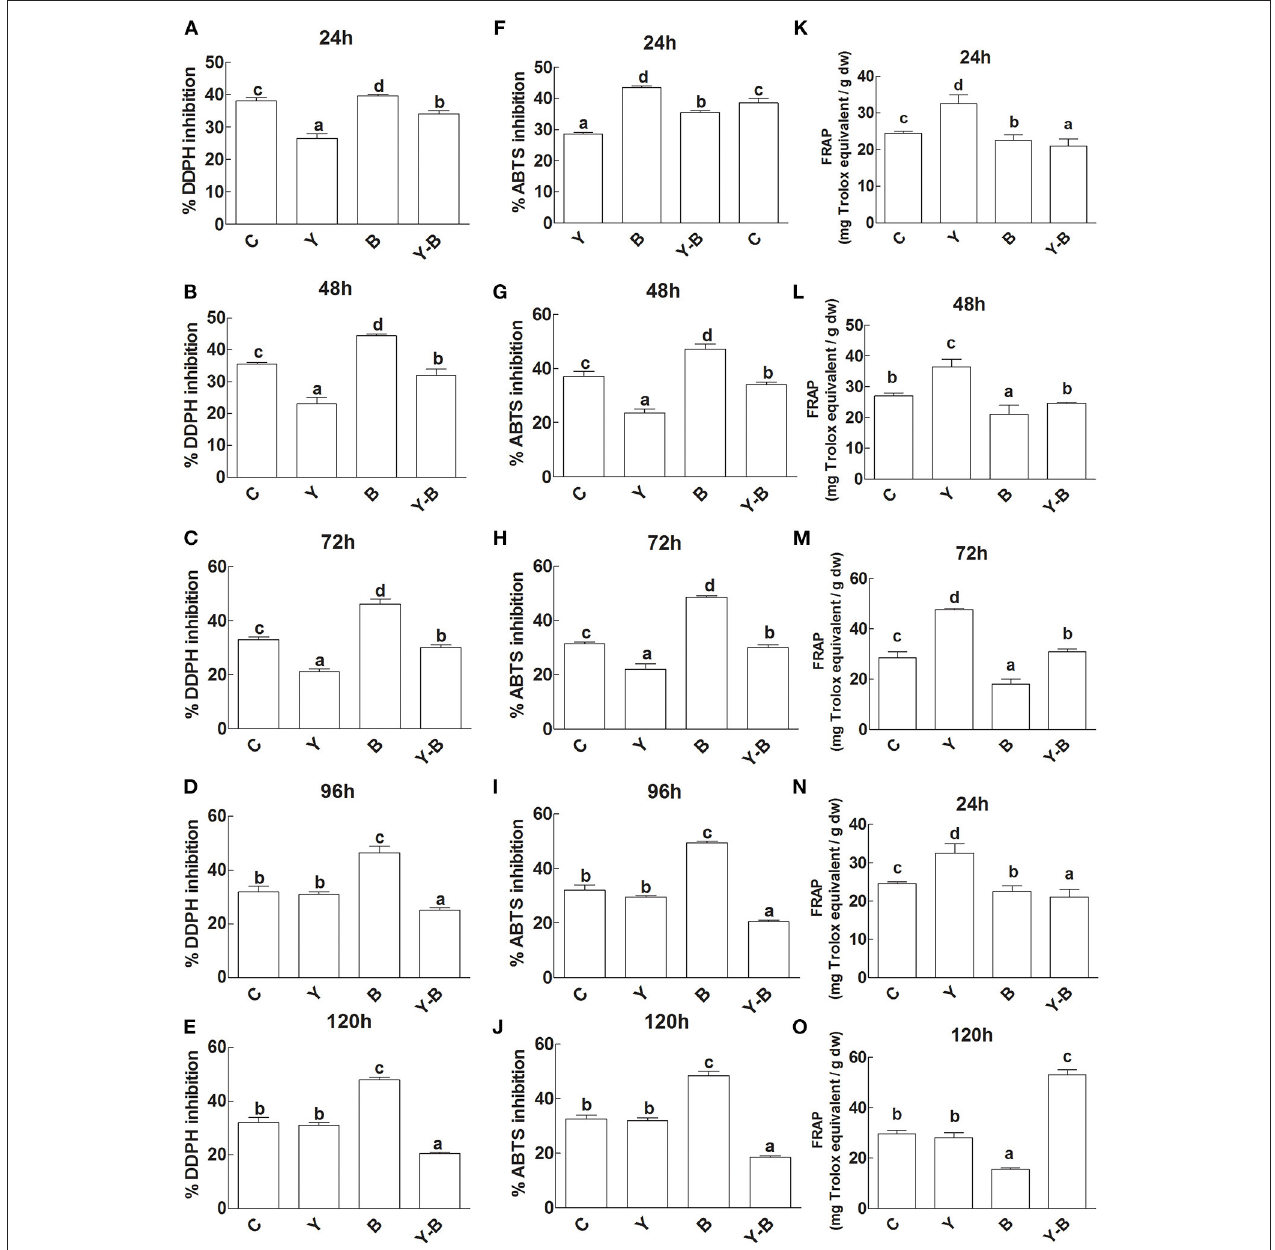
FIGURE 5 | Determination of DDPH inhibition (A–E) , ABTS inhibition (F–J) , and FRAP activity (K–O) in the leaf extracts (LE) and root exudates (RE) of 11-days-old maize seedlings exposed to different treatments including C (control); Y (yucasin), B ( Bipolaris spp.), Y-B (yucasin- Bipolaris spp.) for the different time duration. Data are mean from three independent experiments with standard error bars. Bars labeled with different letters are significantly different (Duncan test; p <